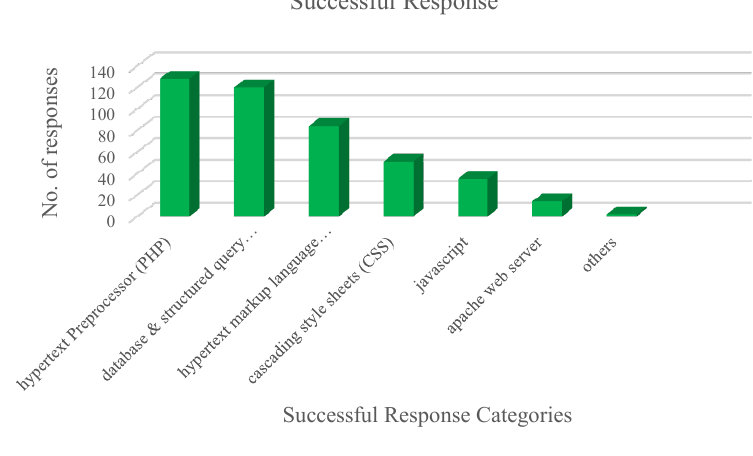
Fig. 7. Successful response categories